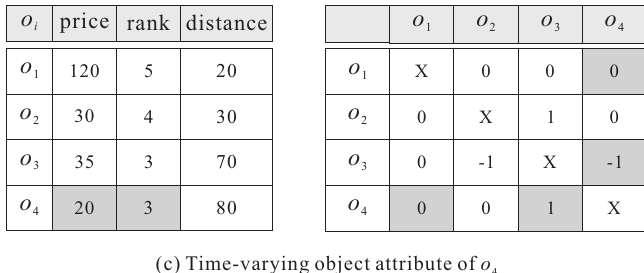
Figure 4. Example of processing the time-varying object